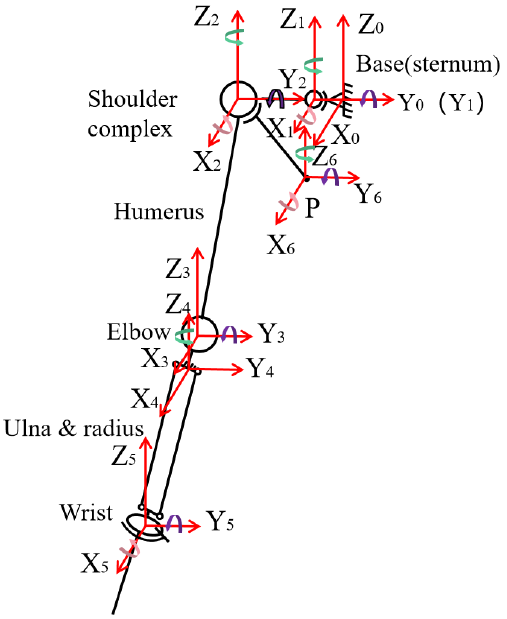
Figure 5. The coordinate systems for the equivalent kinematic model of human